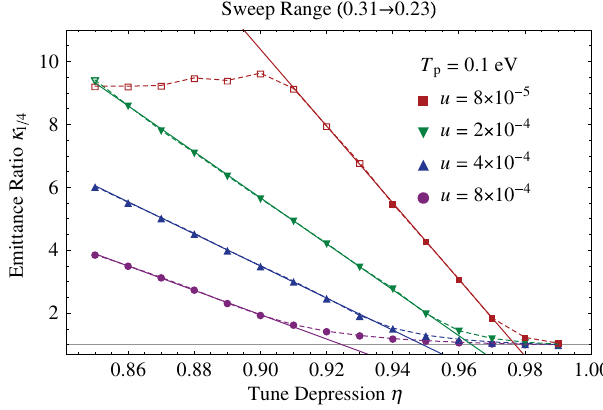
FIG. 16. Examples of WARP simulation data for quarter-integer after cross- resonance crossing. The emittance growth rate (cid:8) 1 = 4 ing the stop band at (cid:5) 0 (cid:3) 1 = 4 is plotted at four different values of u as a function of (cid:3) . The initial plasma temperature T p has been set at 0.1 eV in all simulations here to minimize particle is insensitive to T p as long as particle losses during losses. (cid:8) 1 = 4 resonance crossing are negligible. Open symbols represent the occurrence of finite particle losses. The solid straight lines are fitting results based on the simple function in Eq. The white line in the picture indicates the border below which finite particle losses are detected during the reso- nance crossing. Naturally, the emittance growth becomes more severe for a slower crossing speed and/or higher particle density. Sweep Range 0.31 0.23